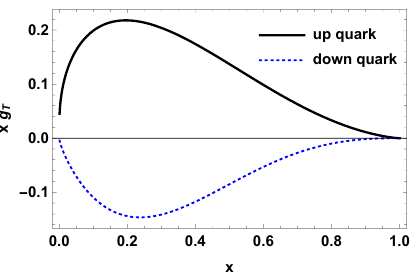
Figure 4: (Color online) The TMDPDF x g ν blue curve correspond to up and do w n quarks